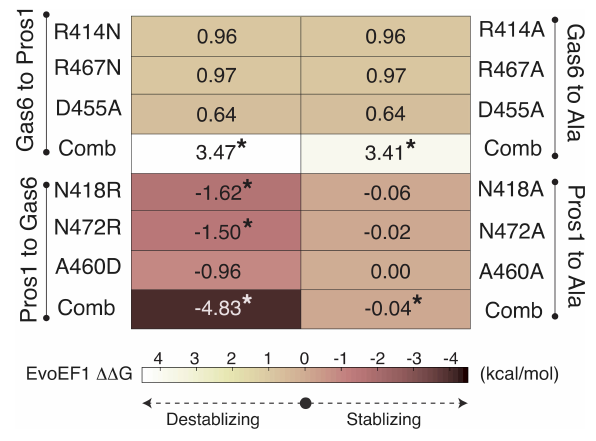
FIGURE 4 | EvoEF1 (cid:52)(cid:52) G predictions for the selective Gas6-to-Pros1 or Pros1-to-Gas6 mutations. R414, R467, and D455 correspond to SB4, SB6, and SB1* forming residues, as presented in Figure 3B . The significant changes are marked with *. The stabilizing and destabilizing mutation color scheme ranges from –4 (brown) to 4 (yellow). Gas6-to-Ala and Pros1-to-Ala mutations were run as a control. Comb refers to combined